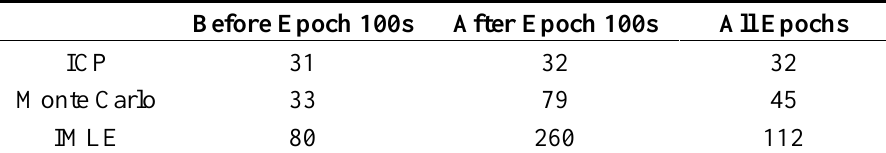
Table 2. Average Cost Time